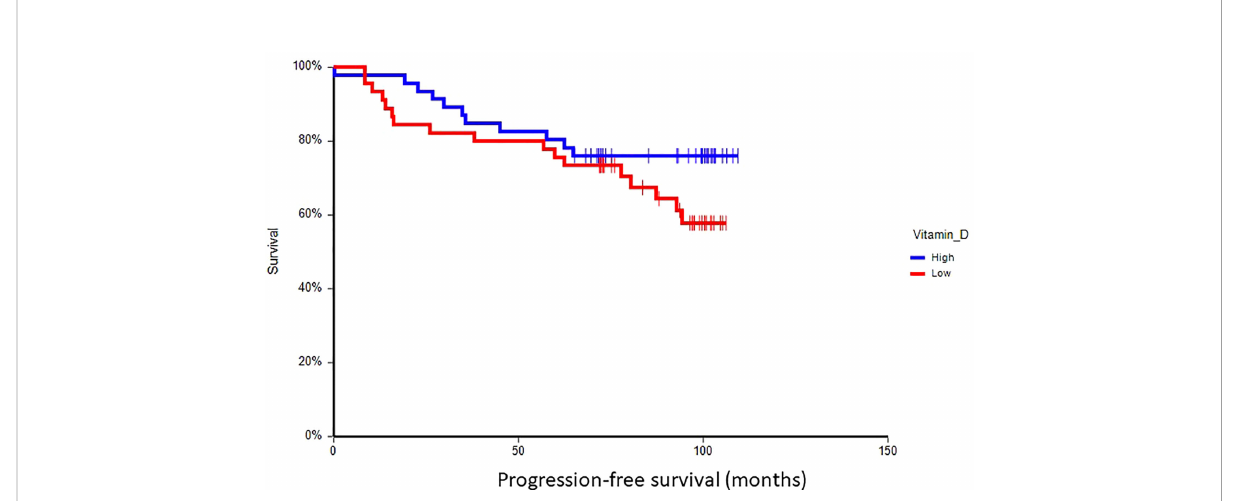
FIGURE 2 Kaplan – Meier estimates of probabilities of disease-free survival according to plasma vitamin D levels in primary breast cancer patients (N = 91). Patients with plasma vitamin D level above median had non-signi fi cantly better DFS as compared to patients with lower vitamin D level (HR = 0.59,